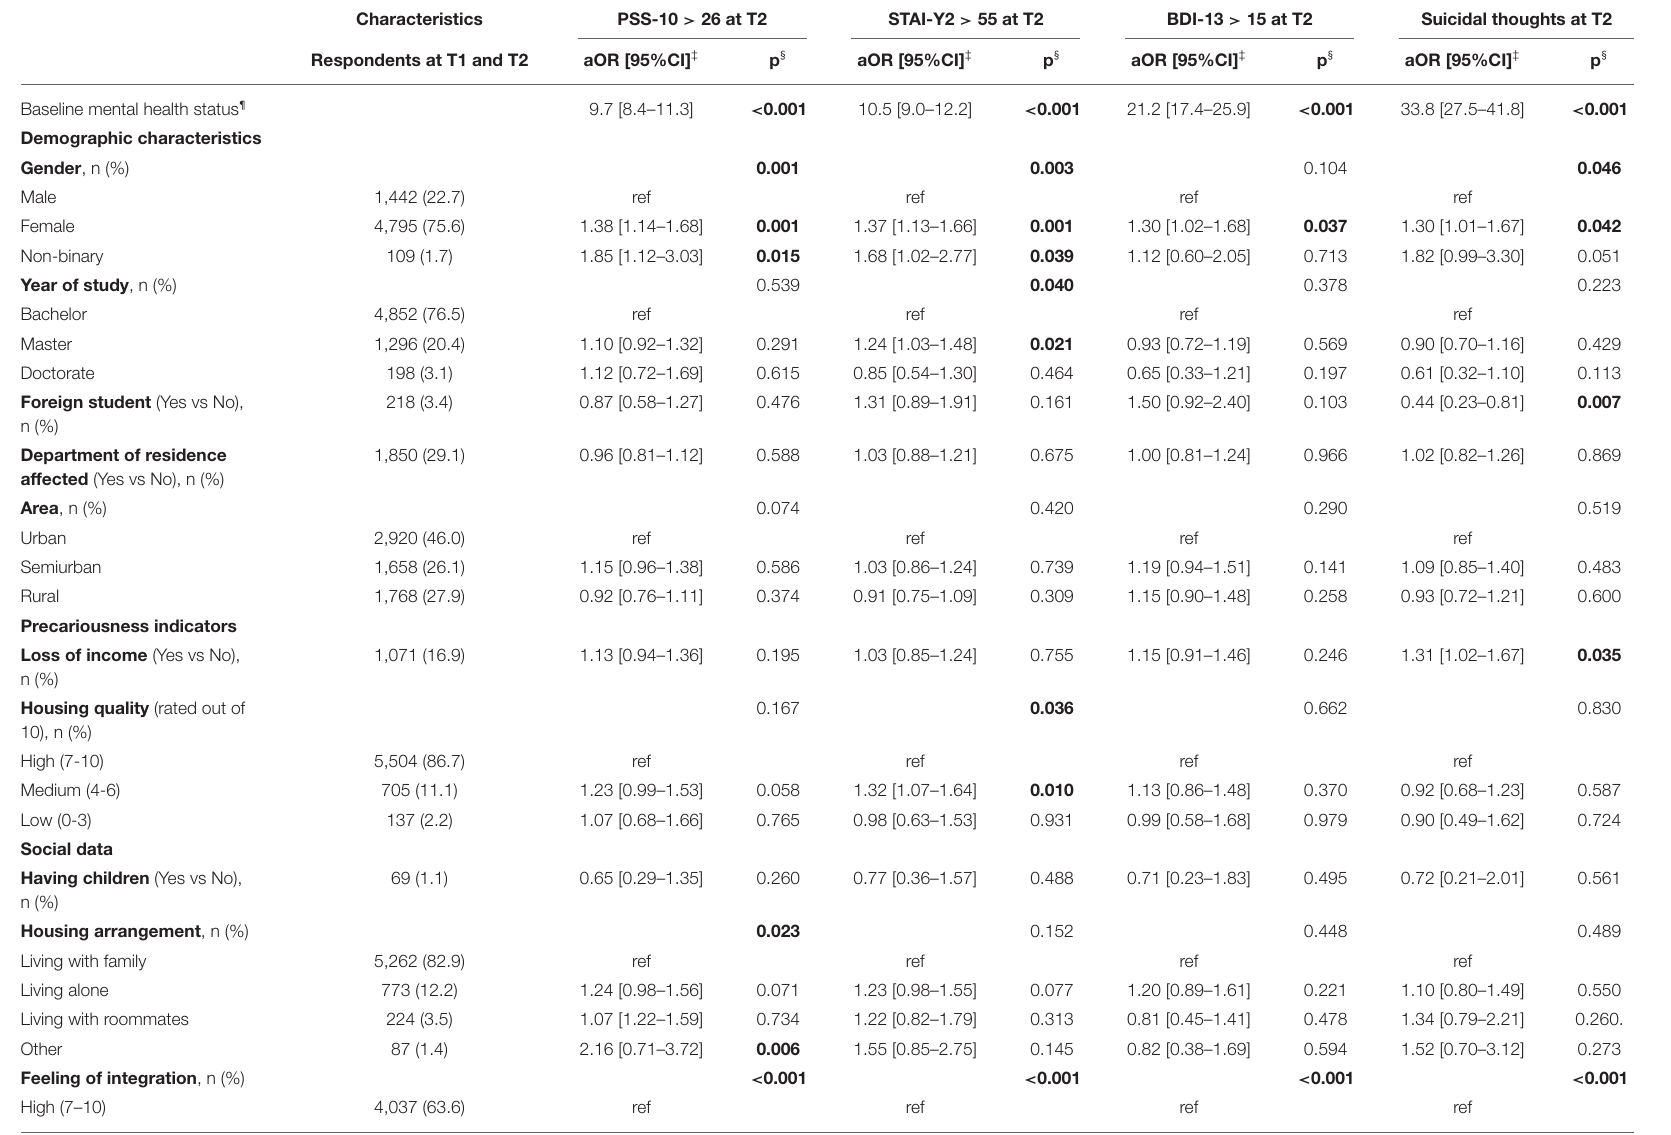
TABLE 3 | Factors associated with severe symptoms at T2 ( n = 6,346): results of the multivariate logistic regression models. Characteristics PSS-10 > 26 at T2 STAI-Y2 > 55 at T2 BDI-13 > 15 at T2 Suicidal thoughts at